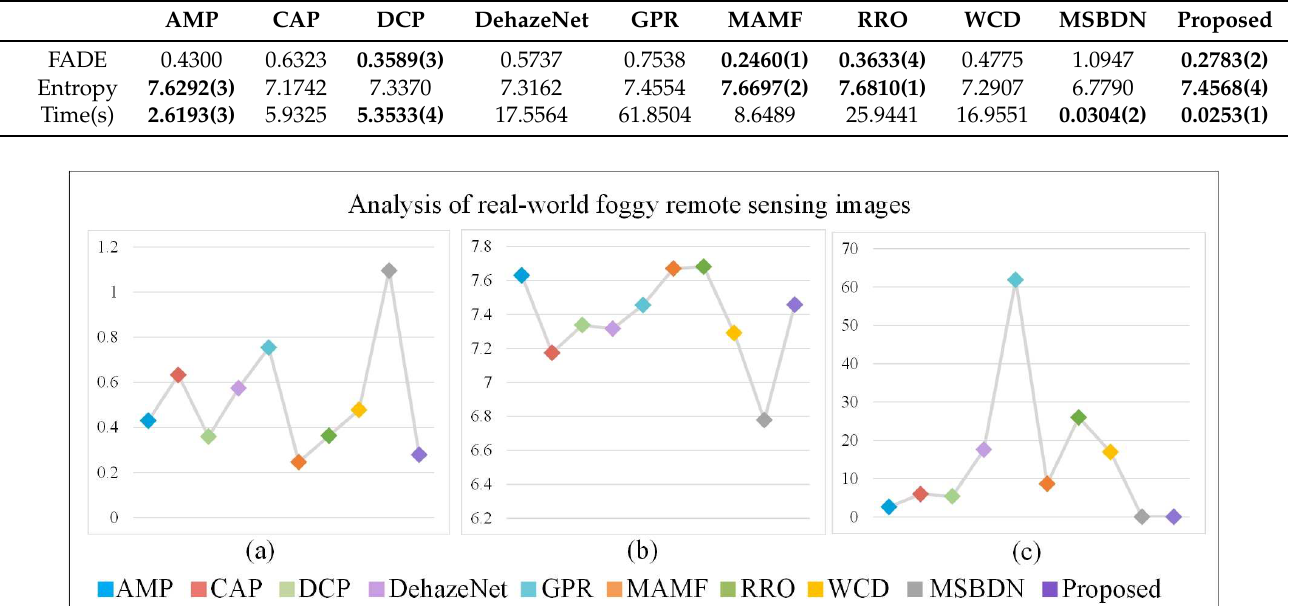
Figure 11. Analysis of ten image defogging methods in real-world foggy remote sensing scenes, ( a ) FADE, ( b ) Entropy, ( c ) processing